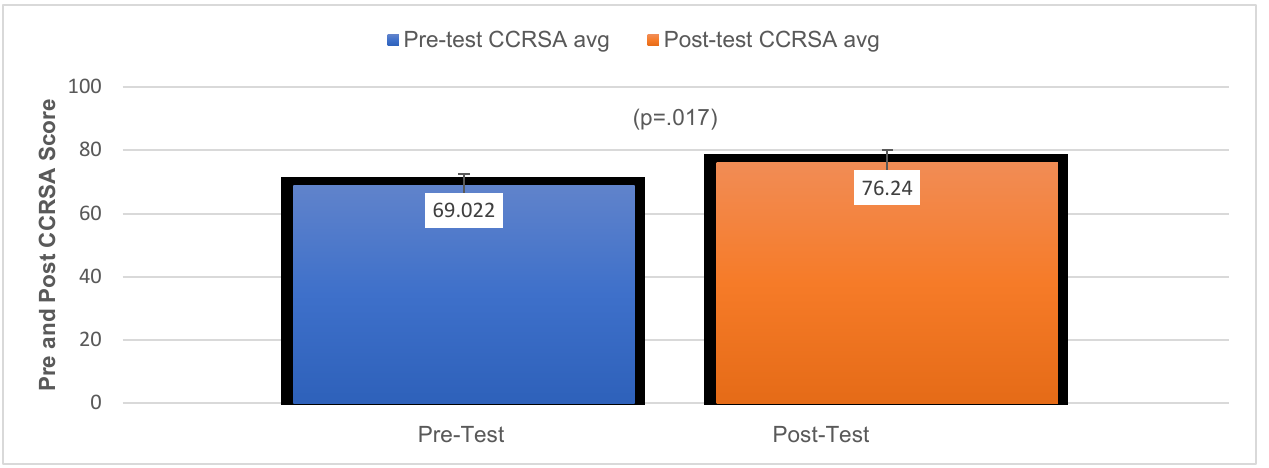
Group Means for CCRSA Pre-Test and Post-Test